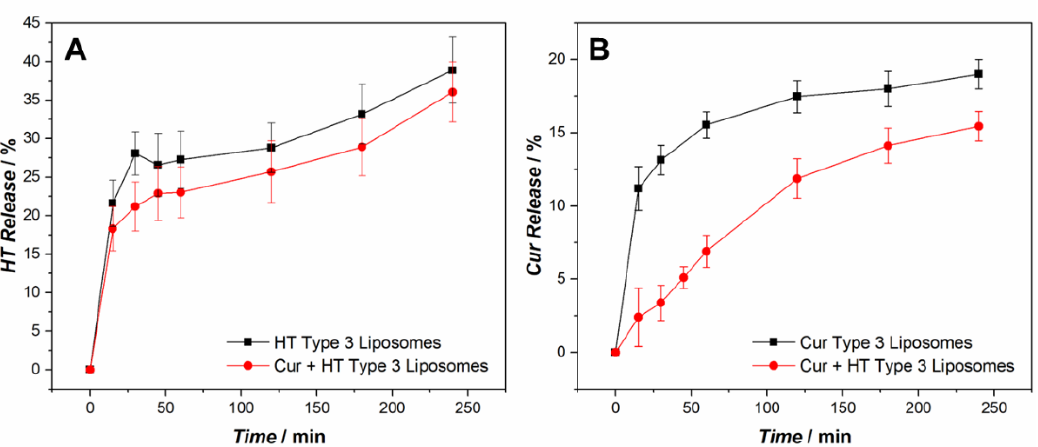
Figure 7. Release profiles of HT ( A ) and Cur ( B ) from Type 3 liposomes in simulated intestinal fluid (pH = 7.4). The black traces refer to liposomes containing only one polyphenol at a time, the red traces to liposomes containing both Cur and HT. The error bars represent the standard deviations of the experiments ( n = 3).